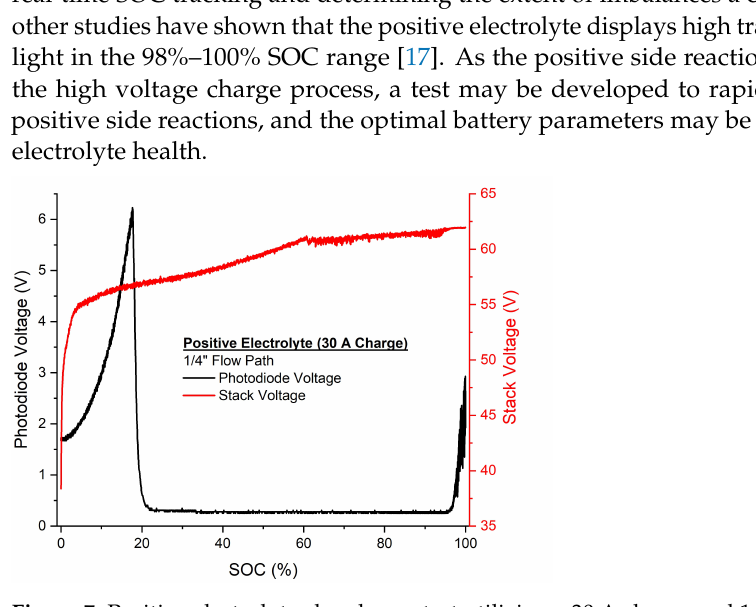
Figure 7. Positive electrolyte absorbance test utilizing a 30 A charge and 1/4 (cid:48)(cid:48) optical path (charge process) [22].